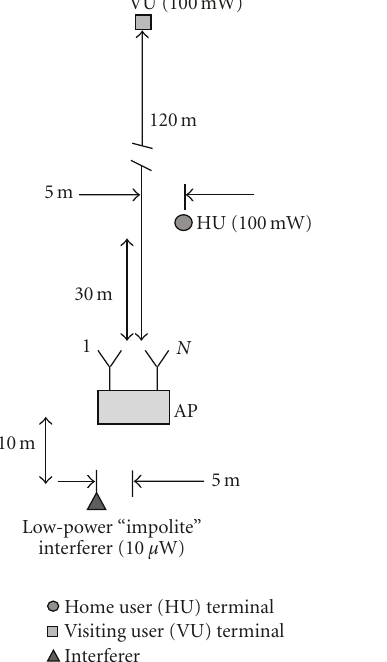
Figure 13: Residential scenario with intersystem interference.